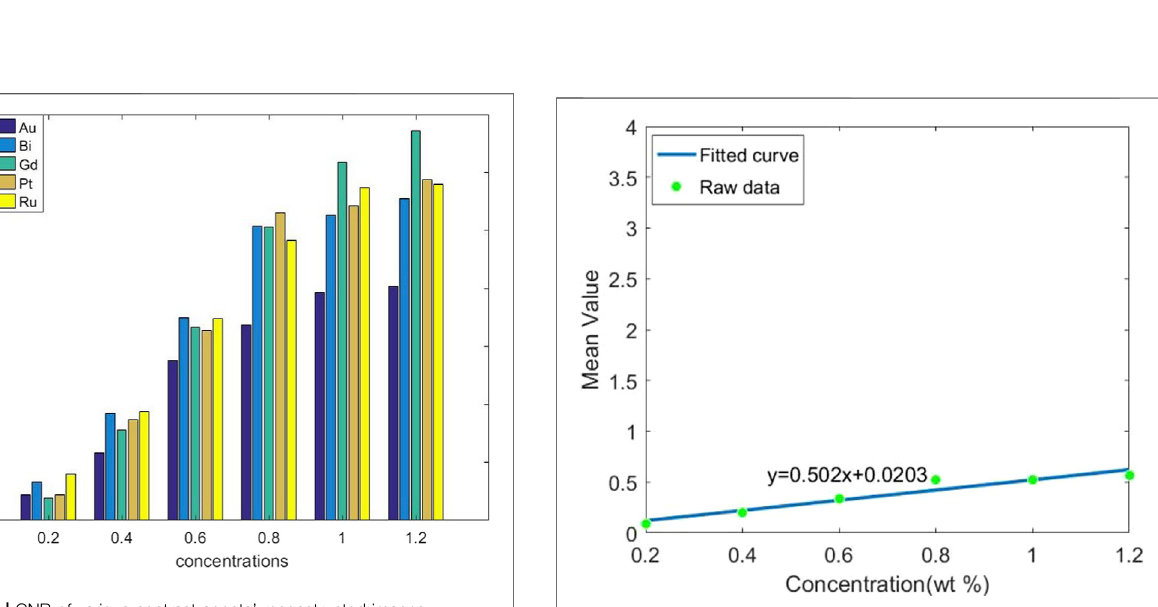
FIGURE 6 | CNR of various contrast agents ’ reconstructed images.